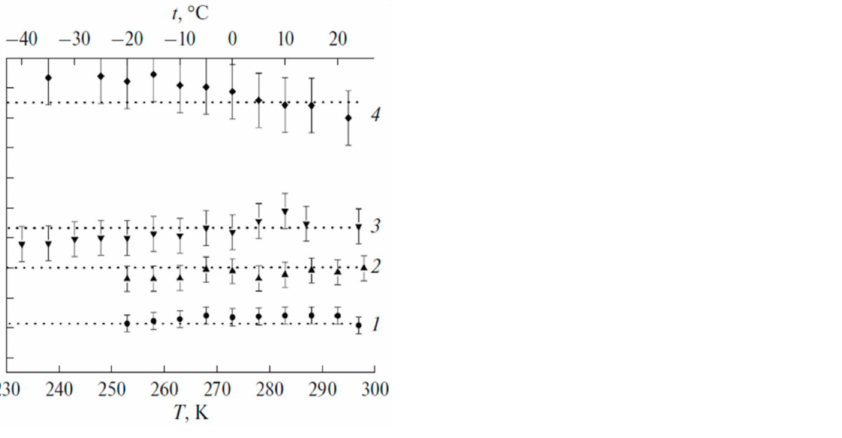
Figure 19. Dependence of the amount of mobile water in the H + form of MSC membranes at different moisture contents in the temperature range from 25 to − 40 ◦ C. The number of water molecules per sulfo group is λ = 5.1 (1), 7 (2), 8.4 (3), 12.5 (4). Reprinted with permission from [16]. Copyright 2020 Springer Nature.